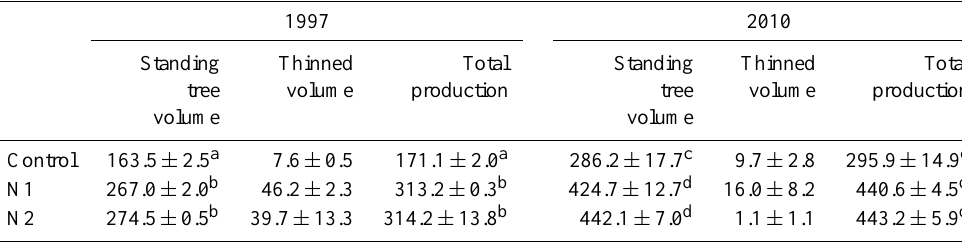
Table 3. Standing tree volume, thinned and total production of stemwood (m 3 on bark ha − 1 ) at Str˚asan. Values are mean ± range ( n = 2). Superscripts ( a , b , c and d ) denote significant differences at P = 0 . 05 (Tukey HSD test). Within columns, means lacking a common superscript differ. Data on diameter at breast height and height in 1997 were obtained from the Unit for Field-based Forest Research database (Swedish University of Agricultural Sciences).